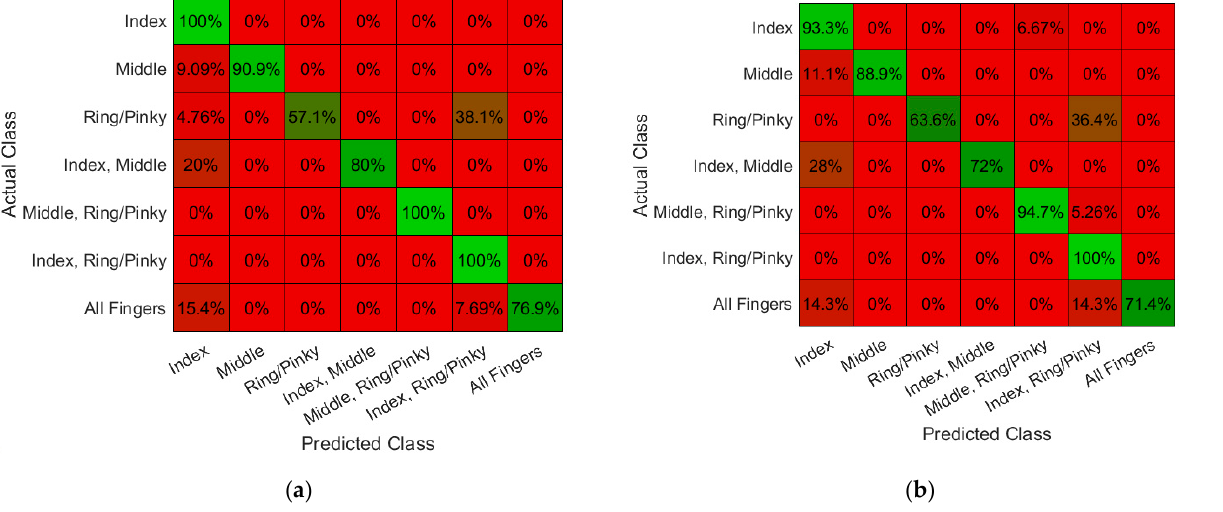
( d ) Figure 11. Offline classification performance and the associated confusion matrices of the trained models for finger gesture detection: ( a ) Test Subject 1; ( b ) Test Subject 2; ( c ) Test Subject 3, and ( d ) Average success rates of the trained models in gesture classification across all test subjects.